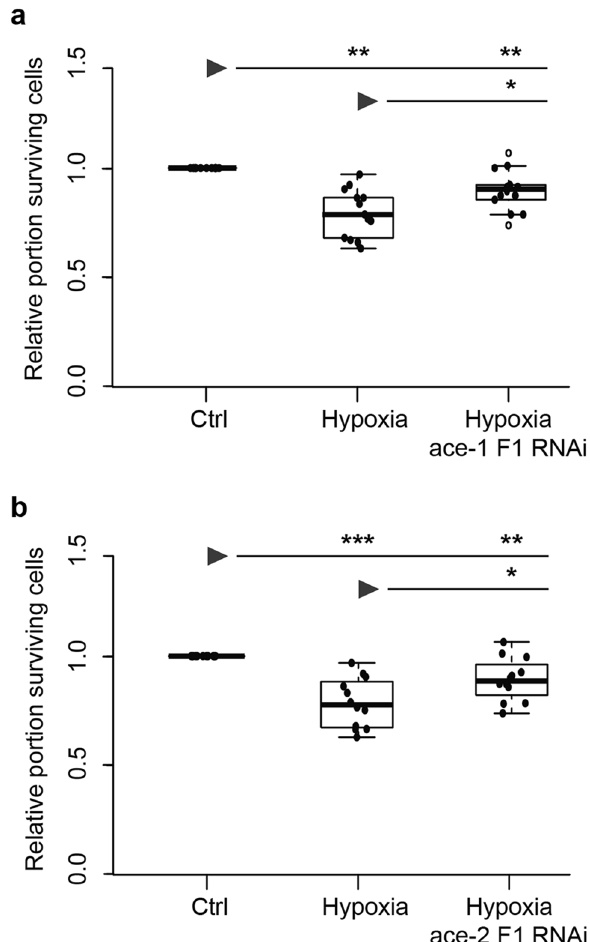
Figure 2. Relative survival of hypoxia-exposed T. castaneum primary neurons after RNAi-mediated knock down of ace-1 and ace-2 expression. Primary cell cultures were maintained for 5 days in vitro with addition of dsRNA before being exposed to hypoxia (< 0.3% O 2 ) for 36 h. Cell survival was analysed by DAPI staining and normalized to the respective untreated control of each experiment (set to 1). ( a,b ) Hypoxia significantly decreased neuron survival in comparison to untreated control cultures. ( a ) Knockdown of ace-1 using fragment 1 significantly increased relative survival of hypoxia-exposed primary neurons. Cell survival is yet significantly lower in comparison to normoxic controls. Empty circles depict outliers. n = 8, 156.006 cells analyzed. ( b ) Knockdown of ace-2 with fragment 1 partially rescues neurons from hypoxia-induced apoptosis. However, relative cell survival is still significantly lower in comparison to normoxic control cultures. n = 12, 145.894 cells analyzed. Statistics with pairwise permutation test and Benjamini–Hochberg correction for multiple comparisons. Significant differences are indicated by asterisks (*p < 0.05; **p < 0.01; ***p <